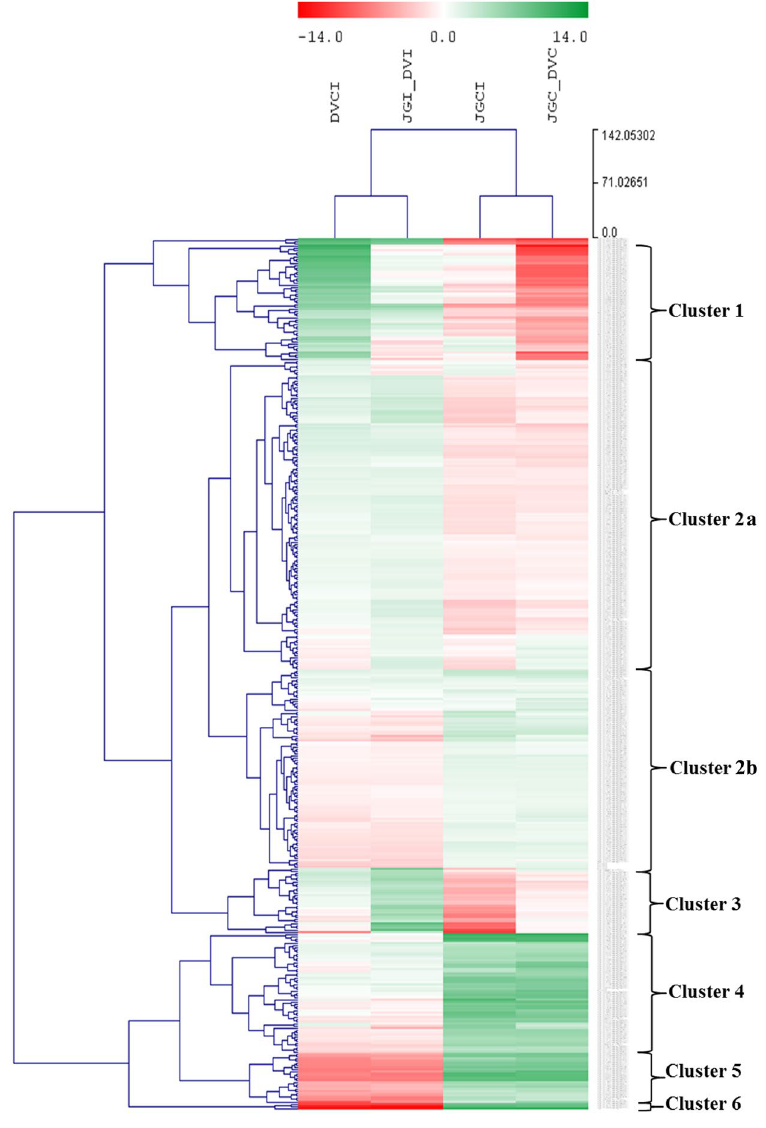
Figure 1. Heatmap and cluster analysis of core DEGs (chickpea) across four datasets. Comparison of significant DEGs among DGE sets resulted in 400 core DEGs (all having LFC ≥ 1 in at least one of the sets). Heatmap was generated with the Log2fold change (LFC) values. Column one represents DE_DVC_DVI (DVCI), column two represents DE_JGI_DVI (JGI_DVI), column three represents DE_JGC_JGI (JGCI) and column four represents DE_JGC_DVC (JGC_DVC). Each row represents corresponding genes with their identities. The list of genes in each cluster is provided in Table S5. Up-regulation and down-regulation is indicated by color change from pale to dark red ( − 14 LFC) and green ( + 14 LFC) with white (0 LFC) representing no change in expression. These genes were clustered using Euclidean distance and complete linkage